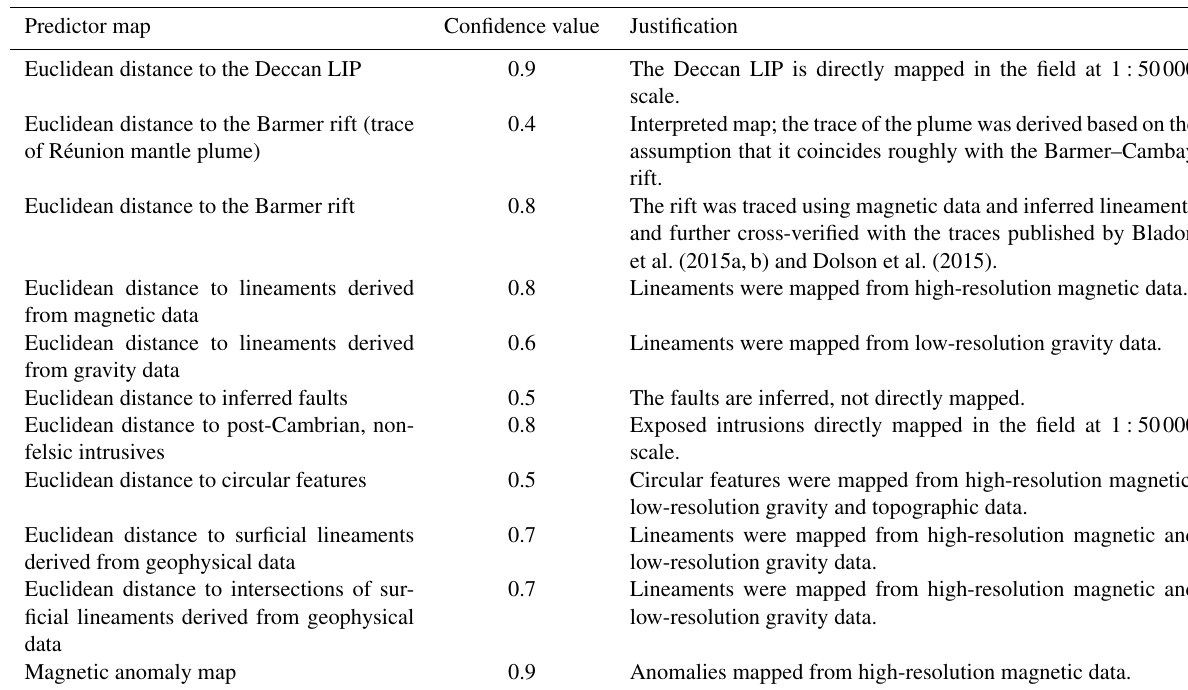
Table 5. Confidence values allotted to each of the predictor maps used in the FIS modelling.